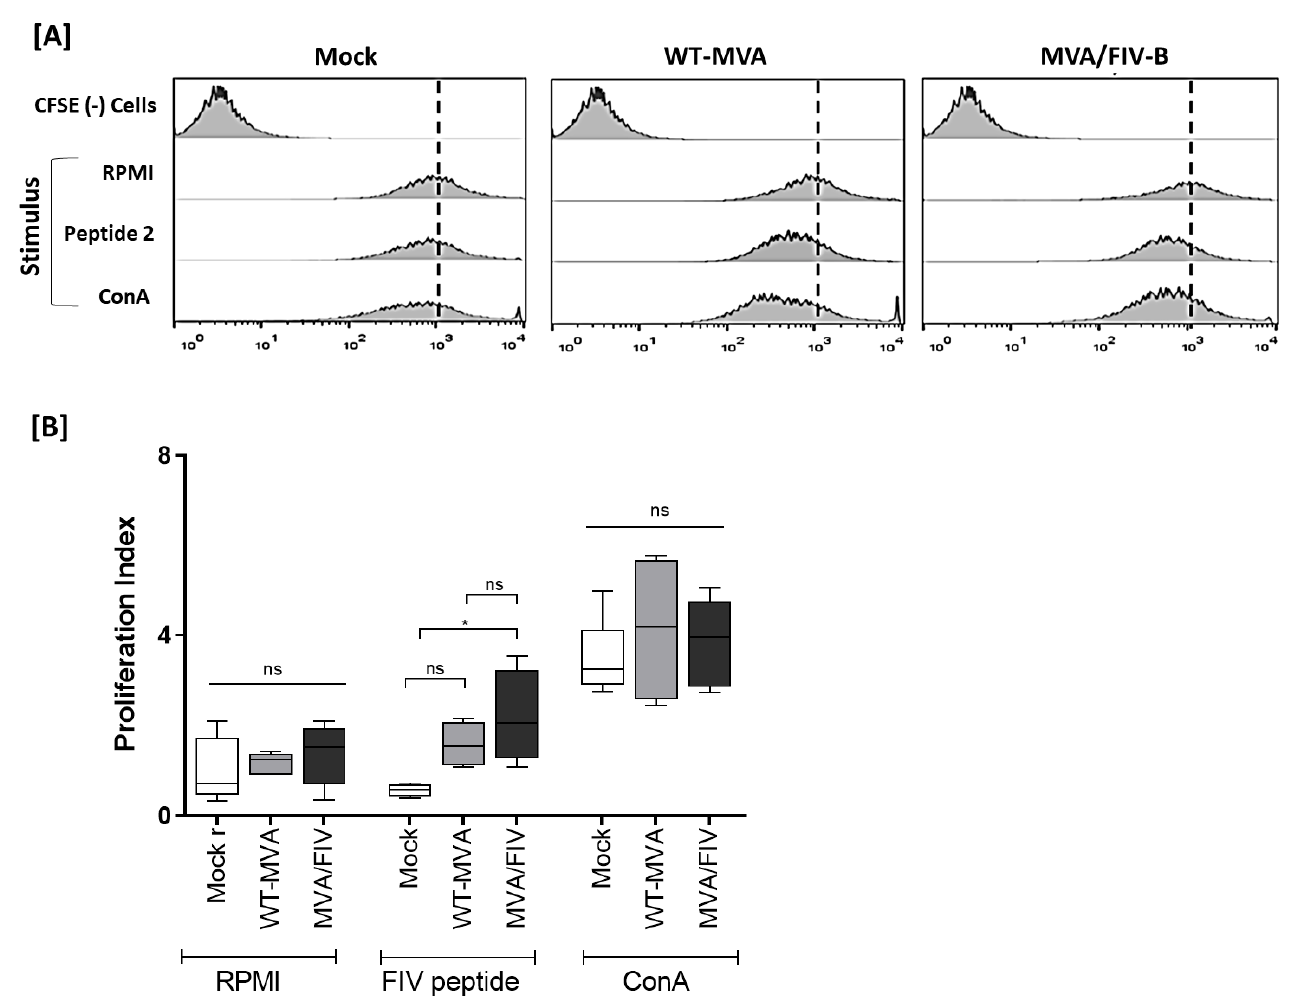
Figure 4. CFSE of splenocytes of the immunized and nonimmunized animals. ( A ) The splenocytes of animals immunized with MVA/FIV, WT-MVA and mock-infected were subjected to different stimuli and compared to unlabeled cells. Shifts are observed at the left side of each graph. ( B ) Proliferation index where it is possible to observe that stimulation by RPMI did not present any statistical difference and maintained a lower proliferation index compared to other stimuli. Peptide stimulation did not significantly differentiate the WT-MVA group with MVA/FIV-B and mock, while the MVA/FIV-B showed a significant difference (* p < 0.05) when compared to mock-inoculated animals, showing a higher proliferation index. Concavalin A (ConA) stimulus was used as a positive control.